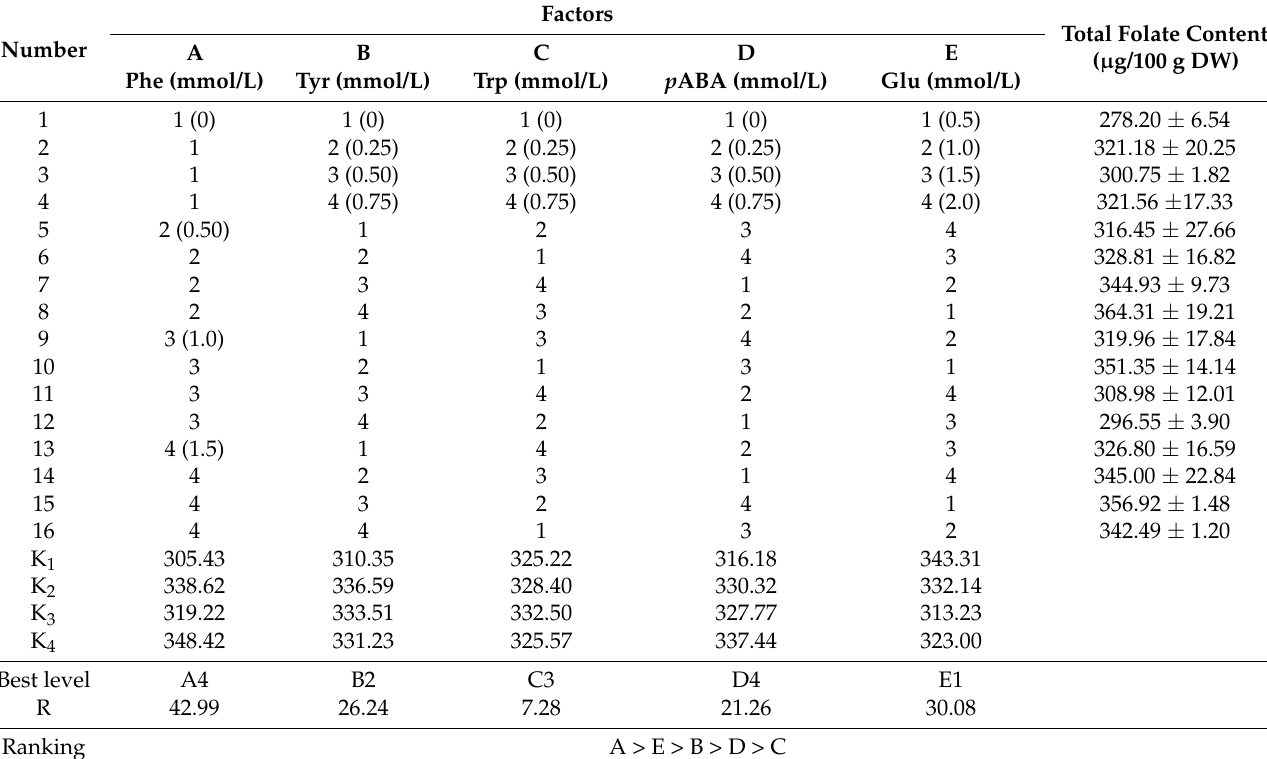
Table 1. Orthogonal experiment on the effect of amino acids on folate accumulation during wheat germination ( n =